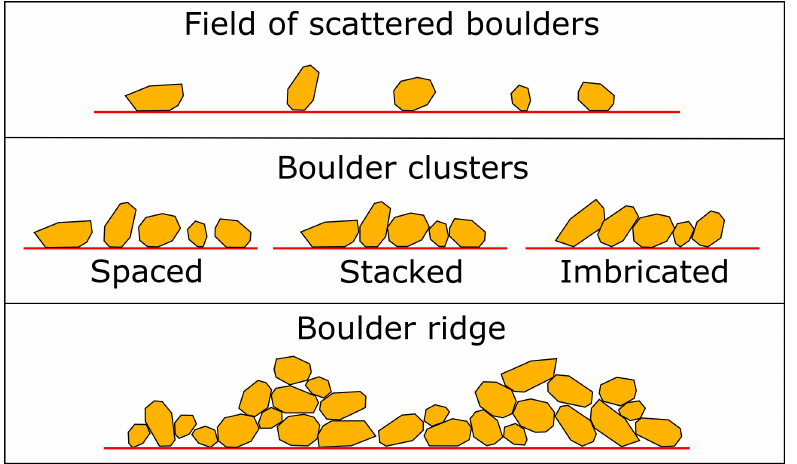
Figure 1. Schematic cross-sections (normal to the coastline) of the CBD assemblage types placed on the shore platform (red line) and produced/activated by high-energy